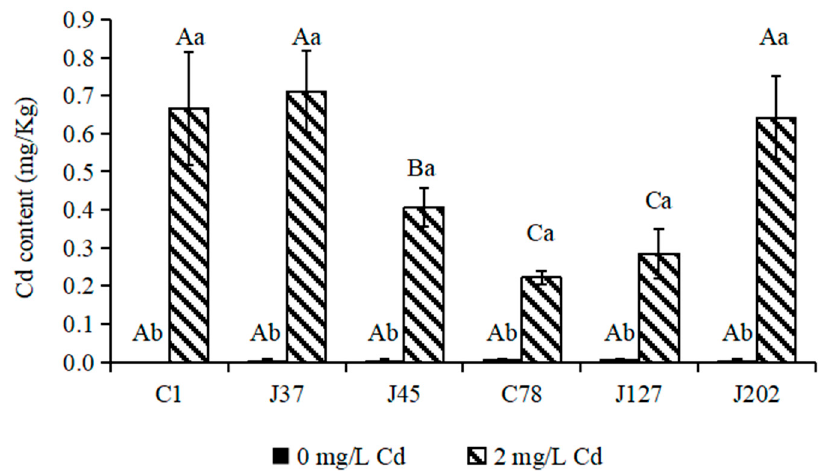
Figure 3. The Cd contents of mycelia of six C. geophilum strains. Uppercase letters indicate between-group differences, lowercase letters indicate within-group differences. Data were shown mean ± SD of replicates ( n = 3). Significant difference of the content of each element of each isolate between 0 mg/L and 2 mg/L Cd concentrations was tested by the Welch t-test (* p < 0.05; ** p < 0.001).